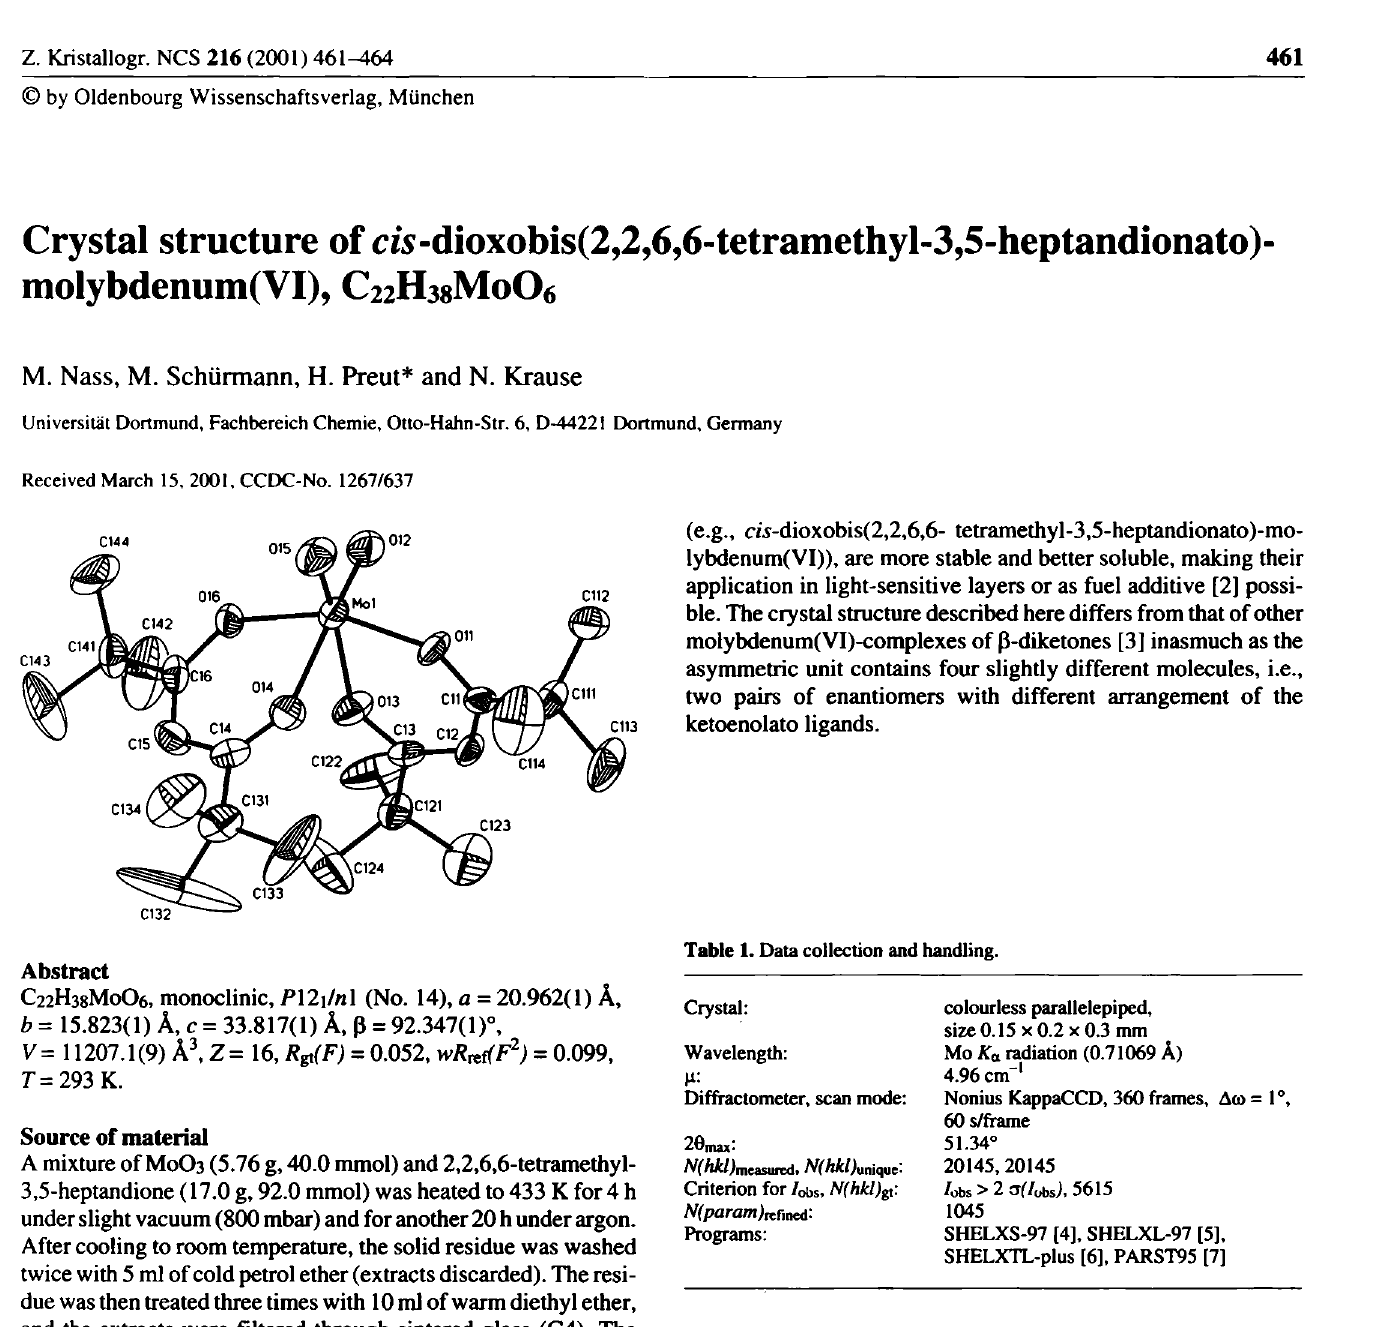
Table 2. Atomic coordinates and displacement parameters (in A 2